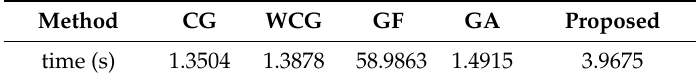
Table 1. The total time consumption of each algorithm on 10,000 star images.